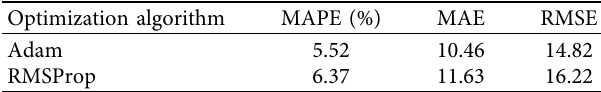
Table 3: Comparison of three evaluation indicators between RMSProp and Adam.